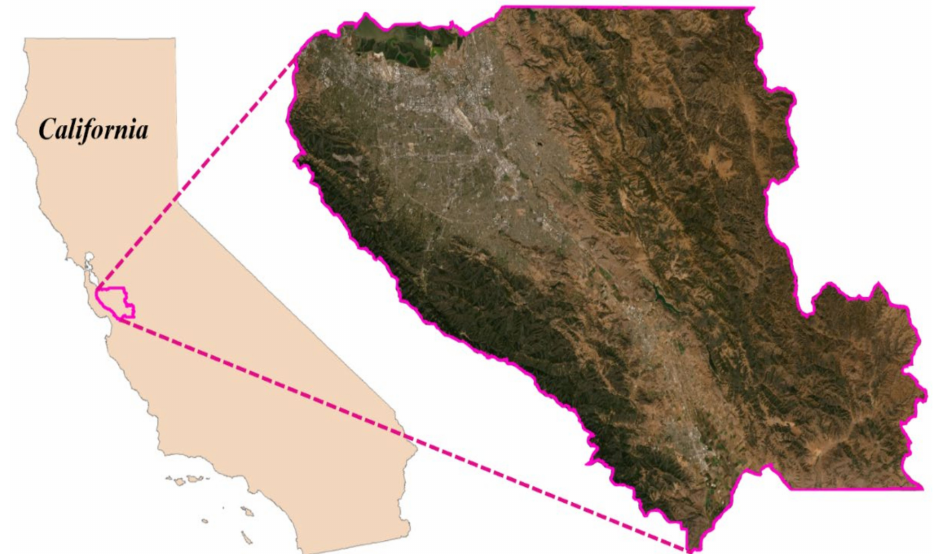
Figure 8. The geographic location of Santa Clara County with respect to the state of